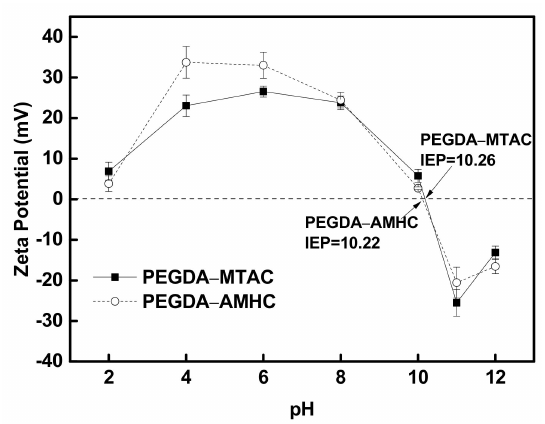
Figure 2. Zeta potentials of PEGDA–MTAC and